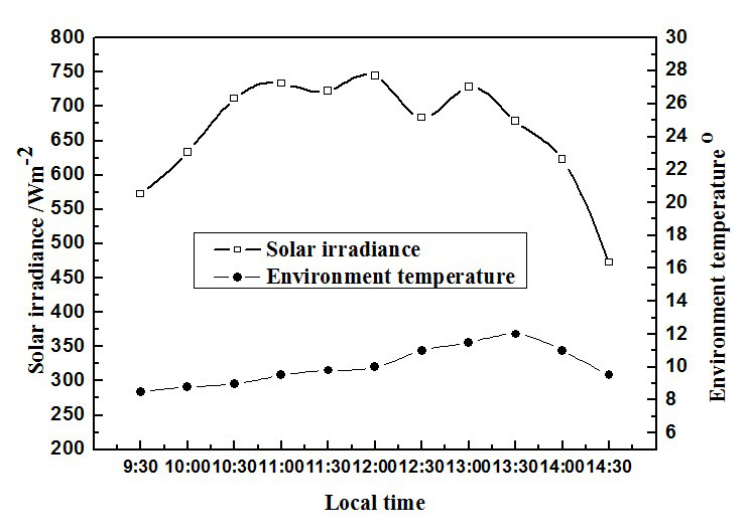
Figure 8. Weather parameter with local time.